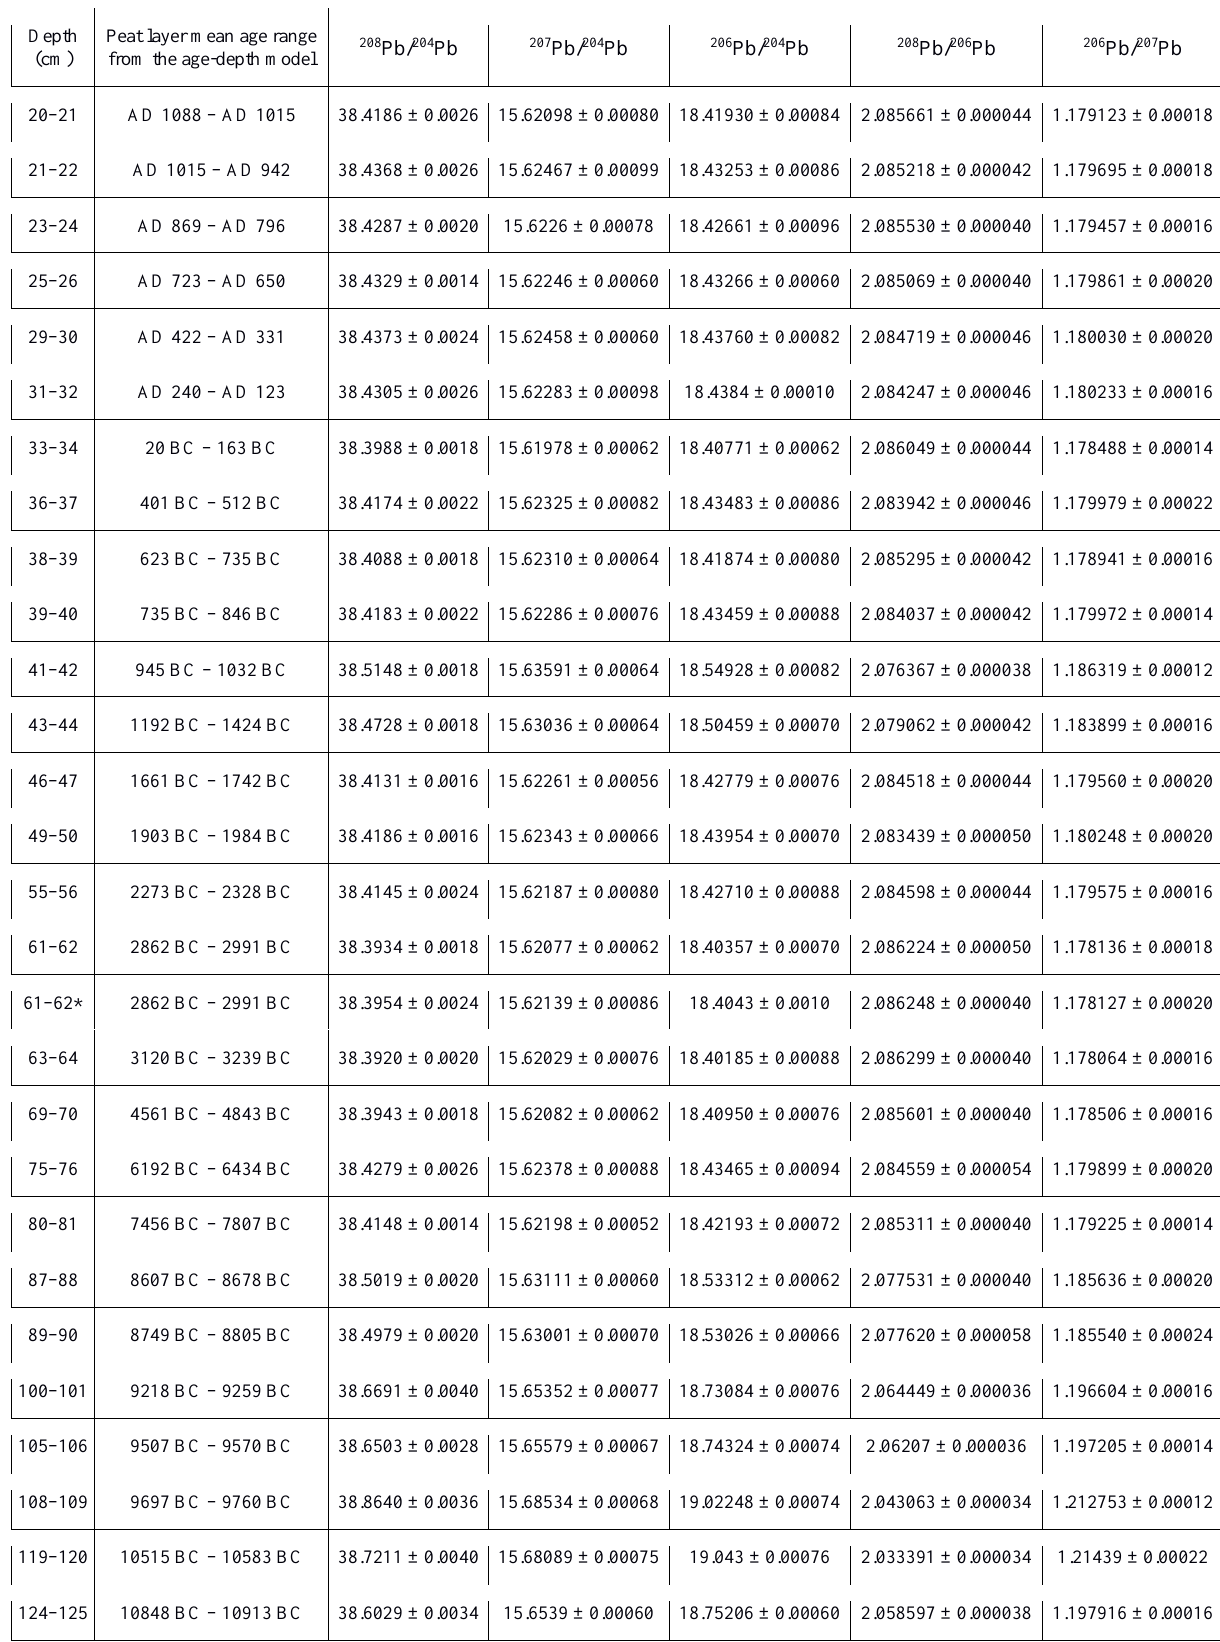
Table 2. Lead isotopic quotient measurements on selected peat samples from Żyglin 3 core. 2σ uncertainty is given. * indicates a